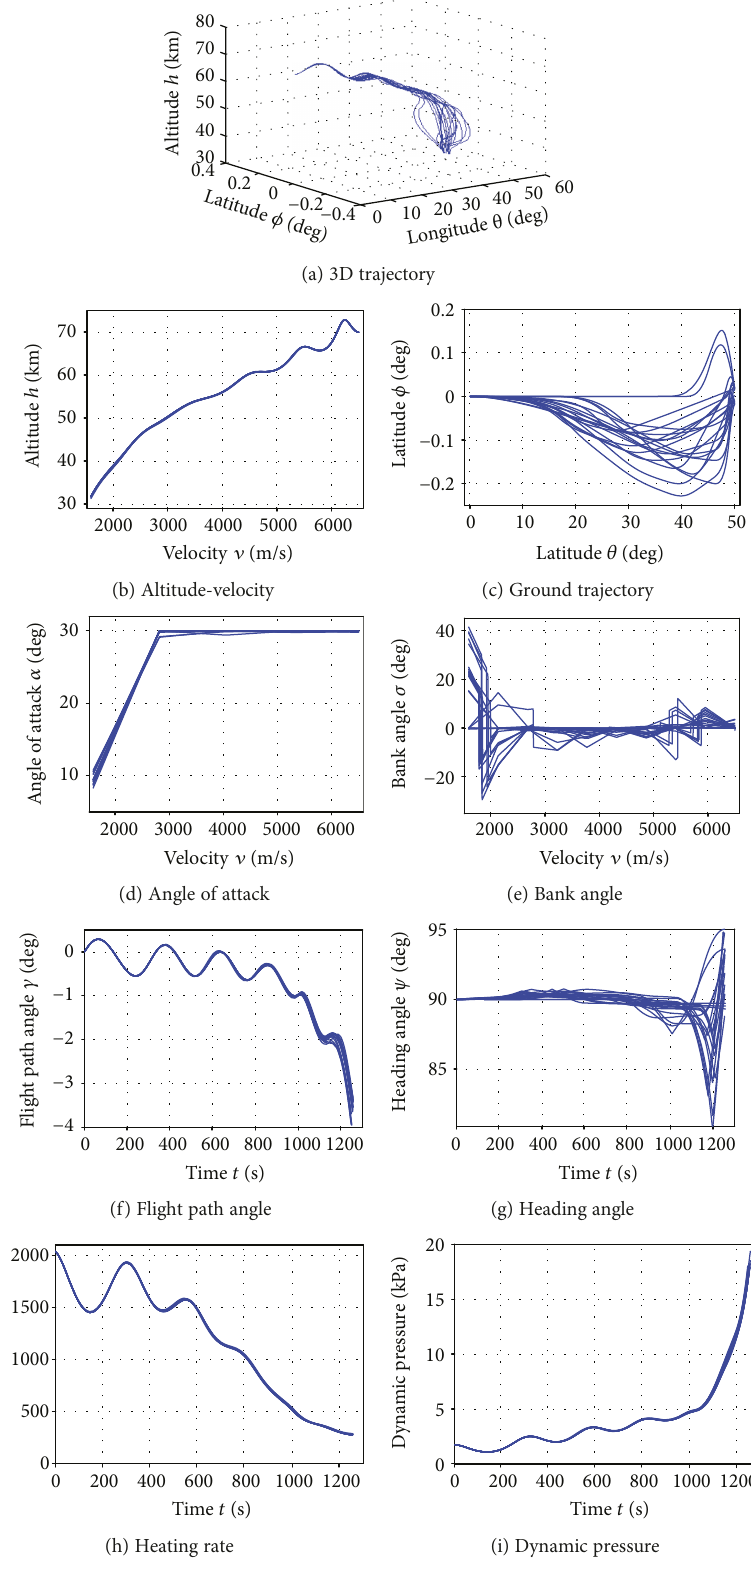
Figure 9: Simulation results of 20 times minimum total heat reentry trajectory optimization using the